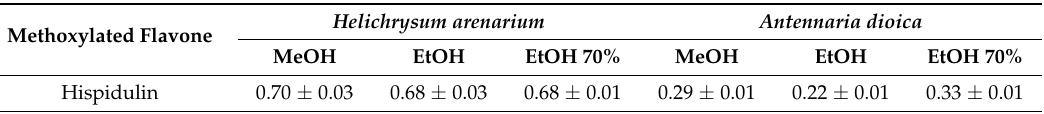
Table 3. The methoxylated flavones identified in the flowers of H. arenarium and A. dioica extract (mg/100 g d.w.).